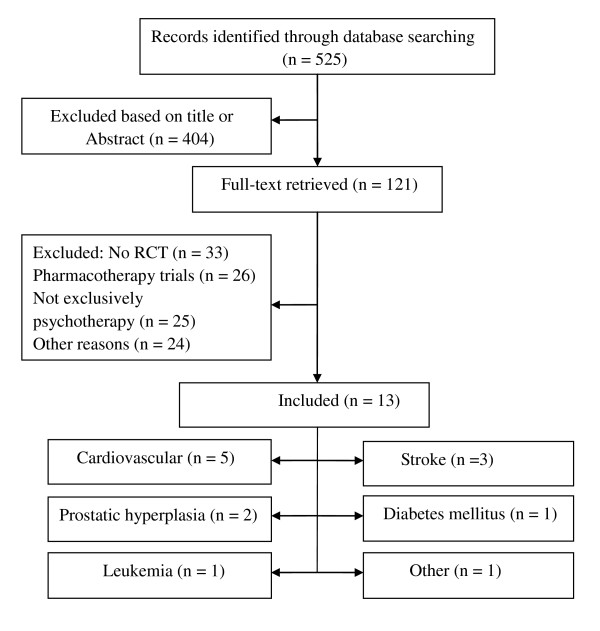
Selection of studies for the review.